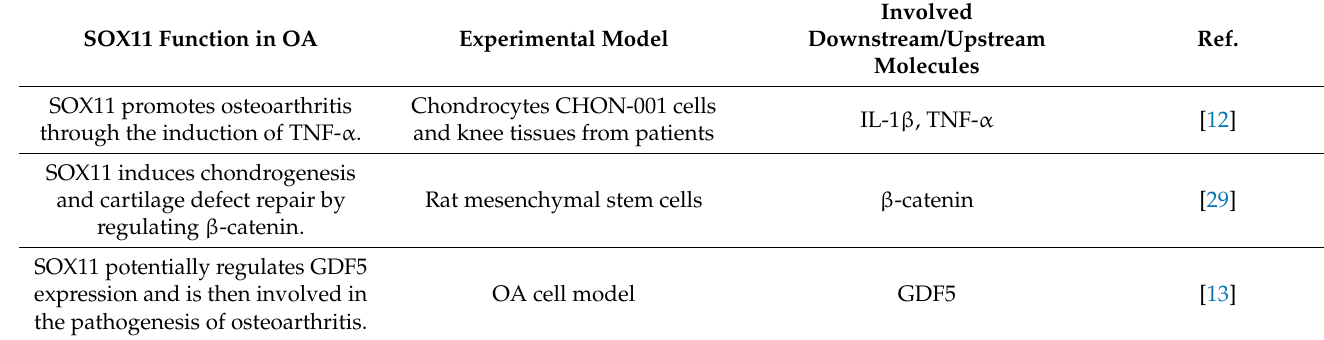
Table 2. SOX11 function during